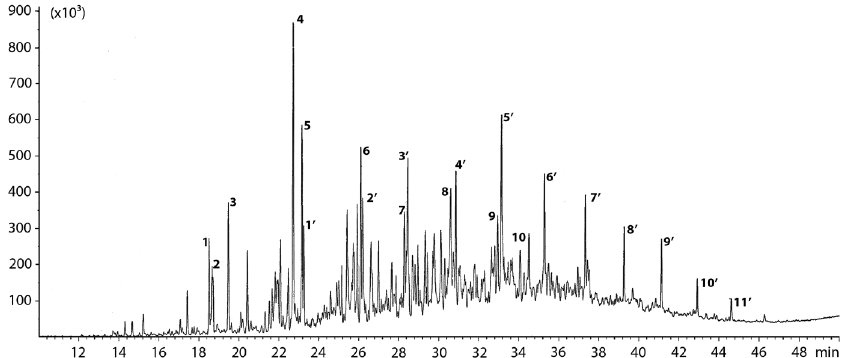
Fig. 6. A GC-MS chromatogram of the aromatic component of the neutral sub-fraction.